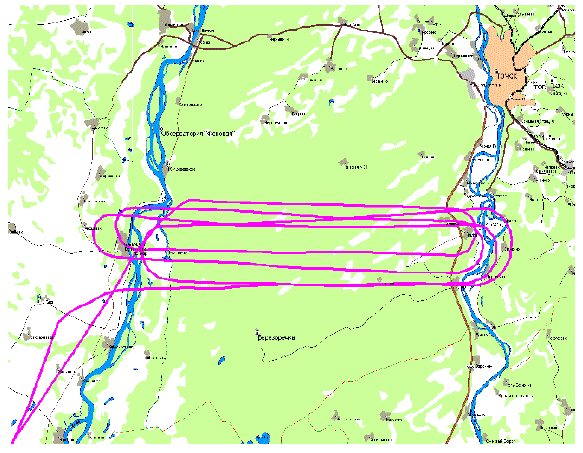
Figure 3. Flight trajectory of the Tu-134 OPTIK flying laboratory on 9 April 2013.